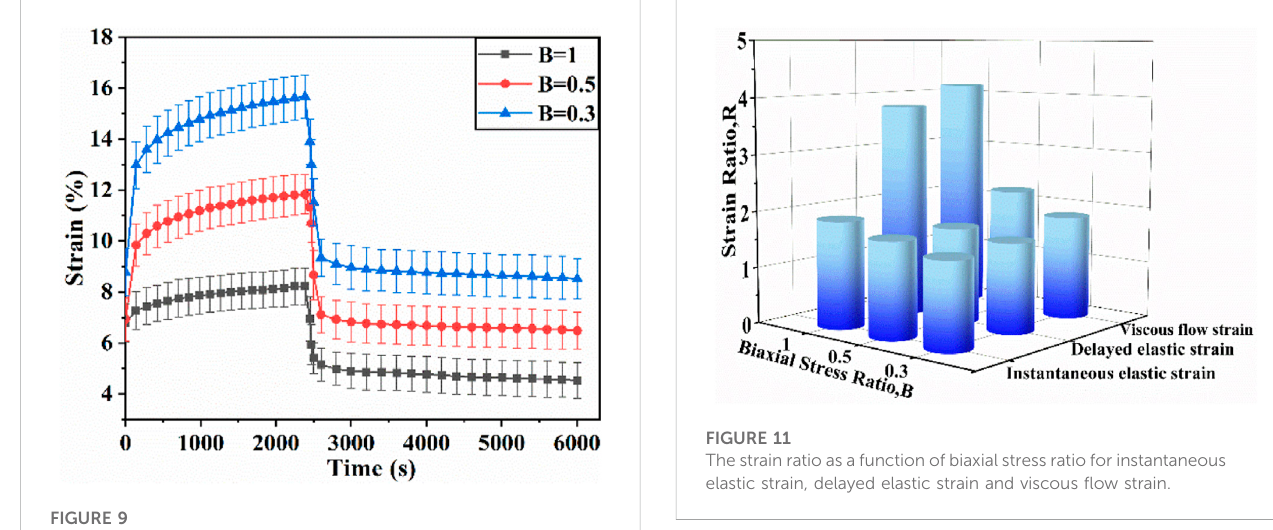
instantaneous elastic strain and increase in proportions of delayed elastic strain and viscous fl ow strain are observed with the increase of stress level.